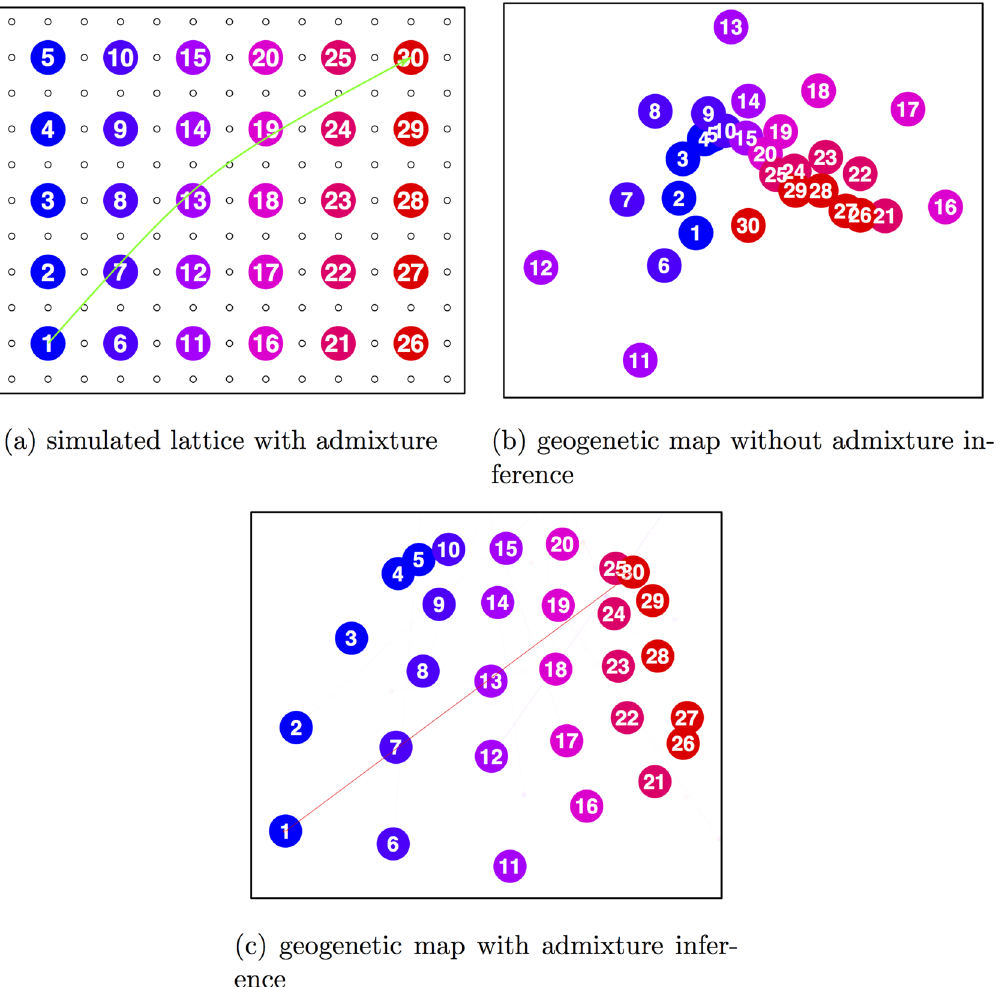
Fig 2. Simulation scenarios and SpaceMix inference. a) a lattice with a recent admixture event between population 1 in the southwest corner and population 30 in the northeast corner, so that population 30 is drawing half of its ancestry from population 1 (a plot showing the first two Principal Component axes for this simulation is given in S2 Fig panel b); b) the estimate of population locations under this scenario; c) the estimate of population locations and their sources of admixture under this scenario. The 95% credible interval on w 30 is 0.36 – 0.40. In panel (c), the width and opacity of the admixture arrows are drawn proportional the admixture